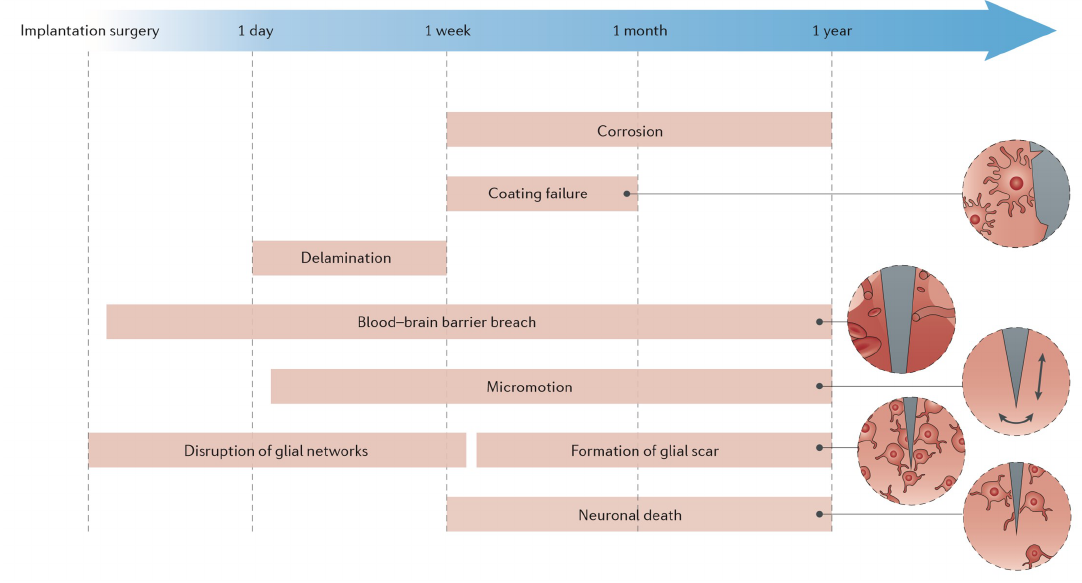
Figure 2. Failure modes of neural probes, manifested as a loss of neural recording capability, can be classified into those related to device design and those related to foreign-body response. Design failure mechanisms include mechanical failure of interconnects, degradation and cracking of the insulation, electrode corrosion and delamination of probe layers. Biological failure mechanisms include initial tissue damage during insertion; breach of the blood-brain barrier; elastic mismatch and tissue micromotion; disruption of glial networks; formation of a glial scar; and neuronal death associated with the above-mentioned factors, as well as with materials neurotoxicity and chemical mismatch. Reprinted by permission from Macmillan Publishers Ltd.: Nature Reviews Materials [45], copyright